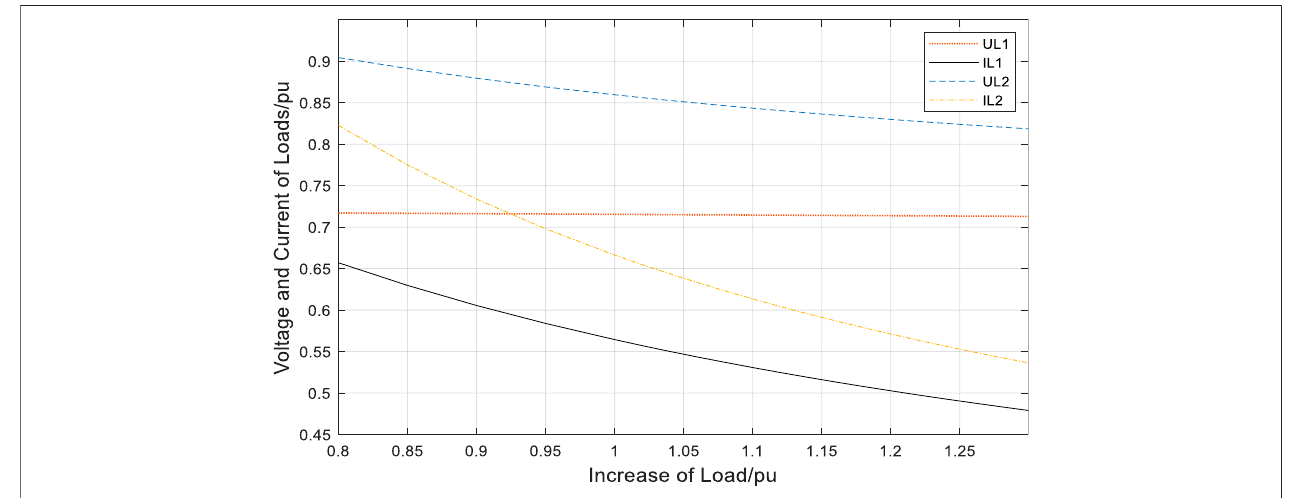
FIGURE 13 | Voltage and current curves on load with the increase of load of the typical APME